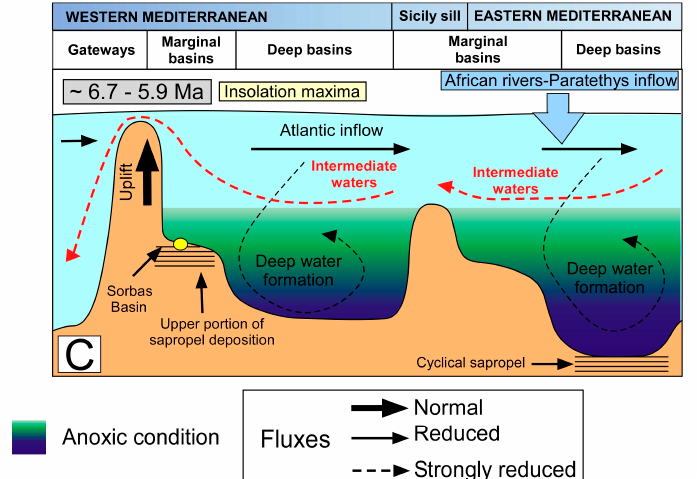
Figure 2. Sketch showing the Late Miocene thermohaline circulation in the Mediterranean in relation with the deposition of sapropel. ( A ): Thermohaline circulation and sapropel deposition (constrained from present circulation pattern and on the basis of the Messinian sedimentary succession) [34,39,41,43,44,47,48], when open marine condition and vigorous thermohaline circulation prevailed. ( B , C ): Thermohaline circulation after the restriction step dated at ~6.7 Ma [41,43,44,47–51] during insolation minima ( B ) and insolation maxima ( C ) periods. Sketch modified after [41].